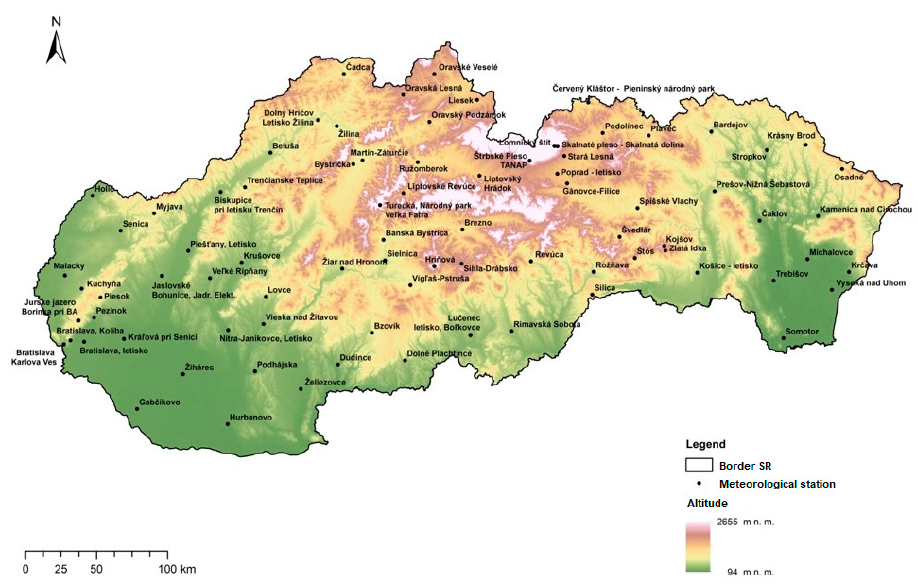
Figure 1. The position of meteorological stations in Slovakia used in this study.